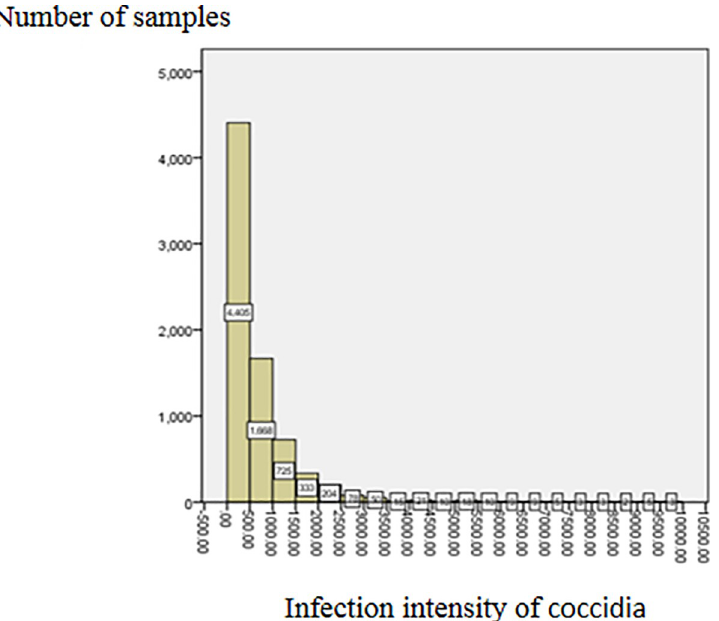
Fig 2. Distribution of sheep GIN infection